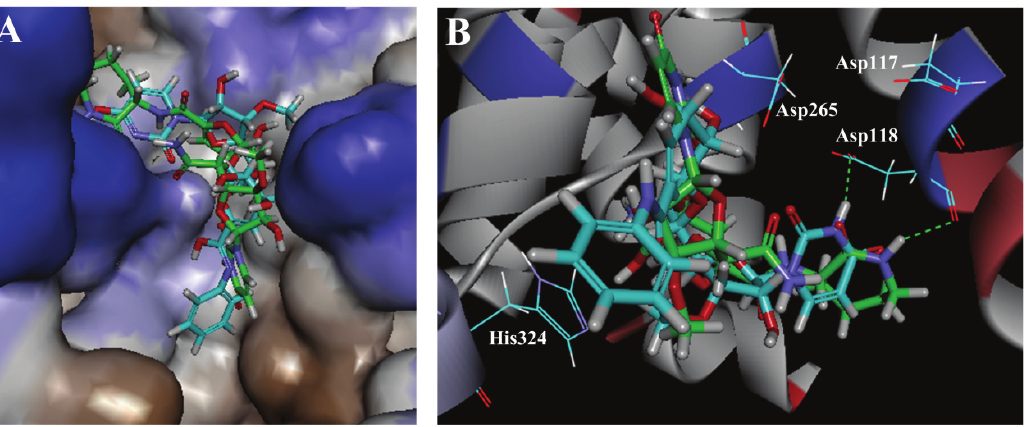
Figure 5: Docking of capuramycin (green) and compound 27 (cyan) with MraY. (A) The protein is represented as a hydrophobicity surface complexed with capuramycin and compound 27. Brown and blue shades represent hydrophobic and hydrophilic regions respectively. (B) Docking of capuramycin and compound 27 with the active site. The H-bonds between MraY and the two compounds are shown as green dashed